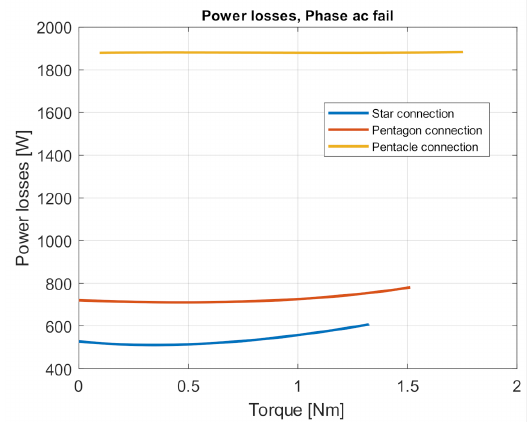
Figure 17. Motor losses, phase failure ac, U IN = 5 × 230 V, 50